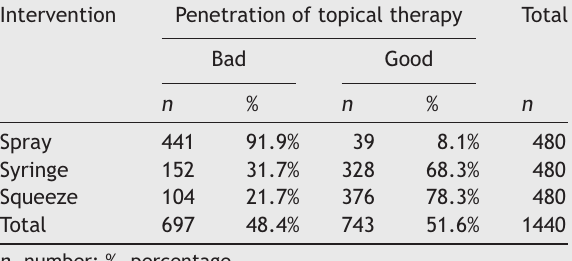
Penetration of topical therapy in each intervention.